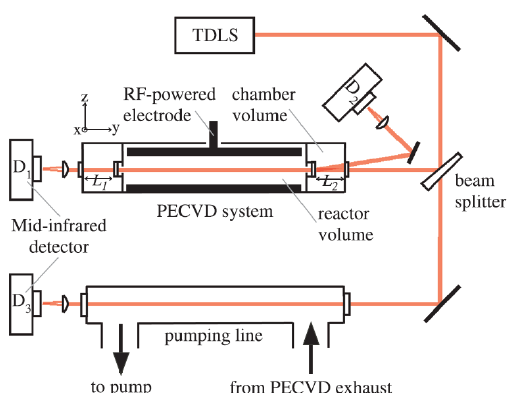
Figure 25. Experimental arrangement of the tunable diode lasers (TDLs), using a cw QCL, and the plasma-enhanced chemical vapor deposition (PECVD) system. Silane is monitored in the reactor volume (D 1 ), in the chamber volume (D 2 ), and in the pumping line (D 3 ) of the PECVD system [57], Reproduced from [57], with the permission of AIP Publishing. Photonics 2016 , 3 , 45